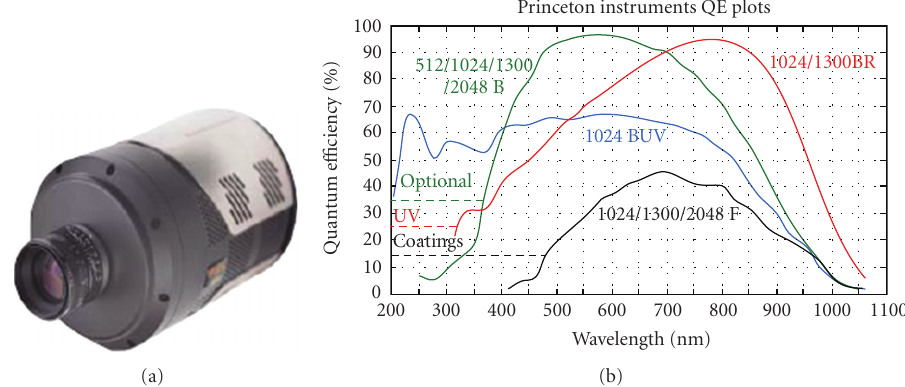
Figure 13: Princeton Pixis thermoelectrically cooled cameras and QE curves for the standard set of E3V scientific detectors available.